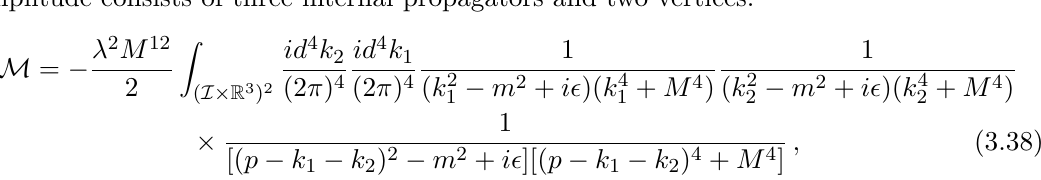
√ = 2 . Right panel: real part of the amplitude with 0